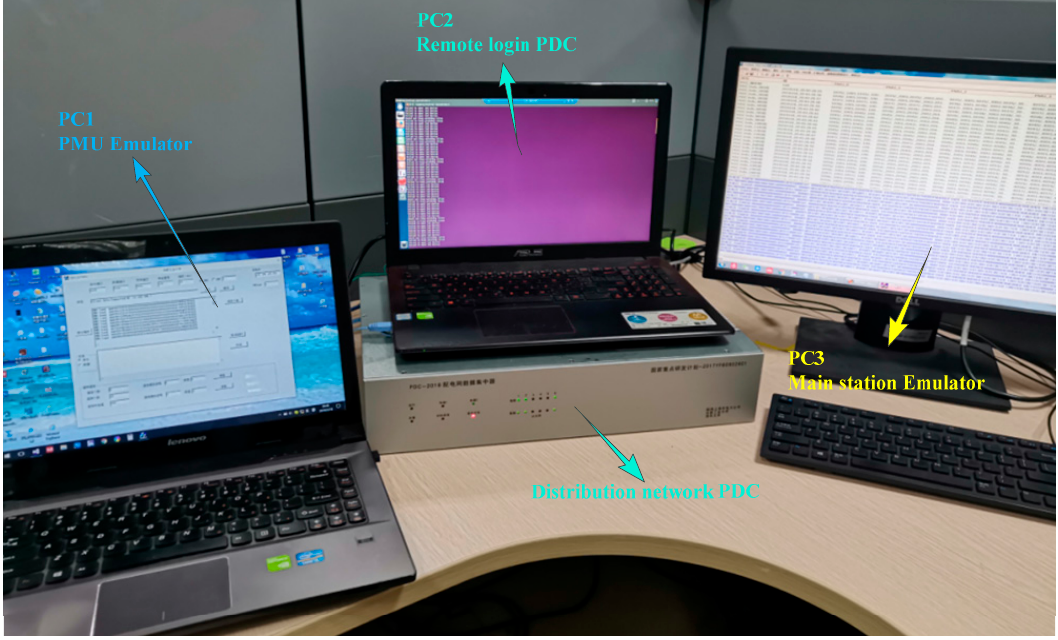
Figure 9. Experimental environment.